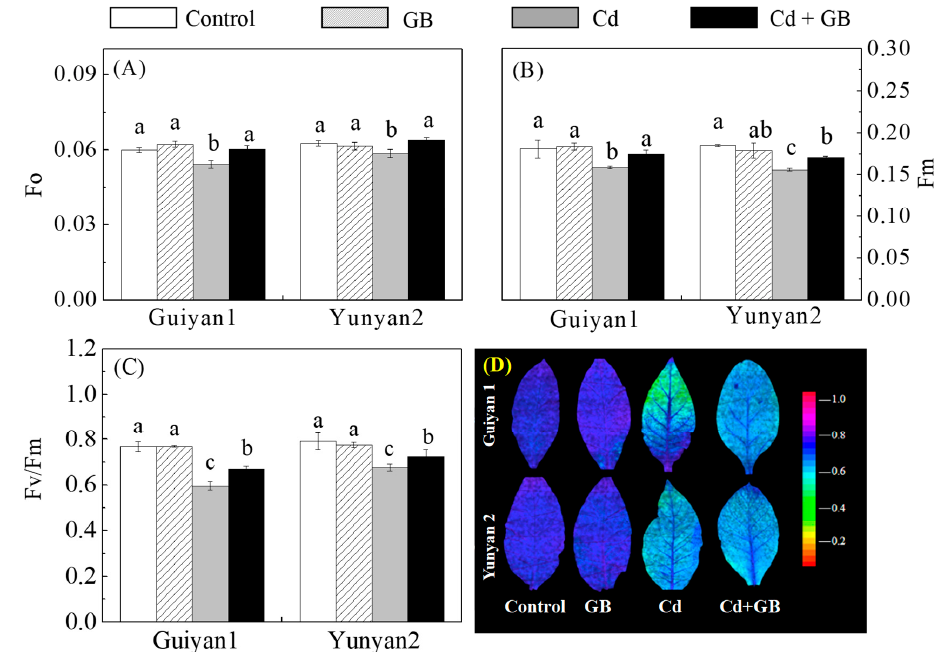
Figure 4. The effects of Cd and exogenous GB on the fluorescence parameters ( A – C ) and the Fv/Fm false color images ( D ) of Guiyan1 and Yunyan2 after 15 days of Cd exposure. Fo, minimal fluorescence yield ( A ); Fm, maximal fluorescence yield ( B ); and Fv/Fm, maximum quantum yield of PSII ( C ). The error bars represent the SD values ( n = 3). The different letters indicate the significant differences ( p < 0.05) among the 4 treatments within each cultivar. Control, GB, Cd, and Cd + GB correspond to BNS + foliar spray of deionized water, BNS + foliar spray of 500 μ M GB, BNS + foliar spray of deionized water + 5 μ M CdCl 2 and BNS + foliar spray of 500 μ M GB + 5 μ M CdCl 2 , respectively. The figure